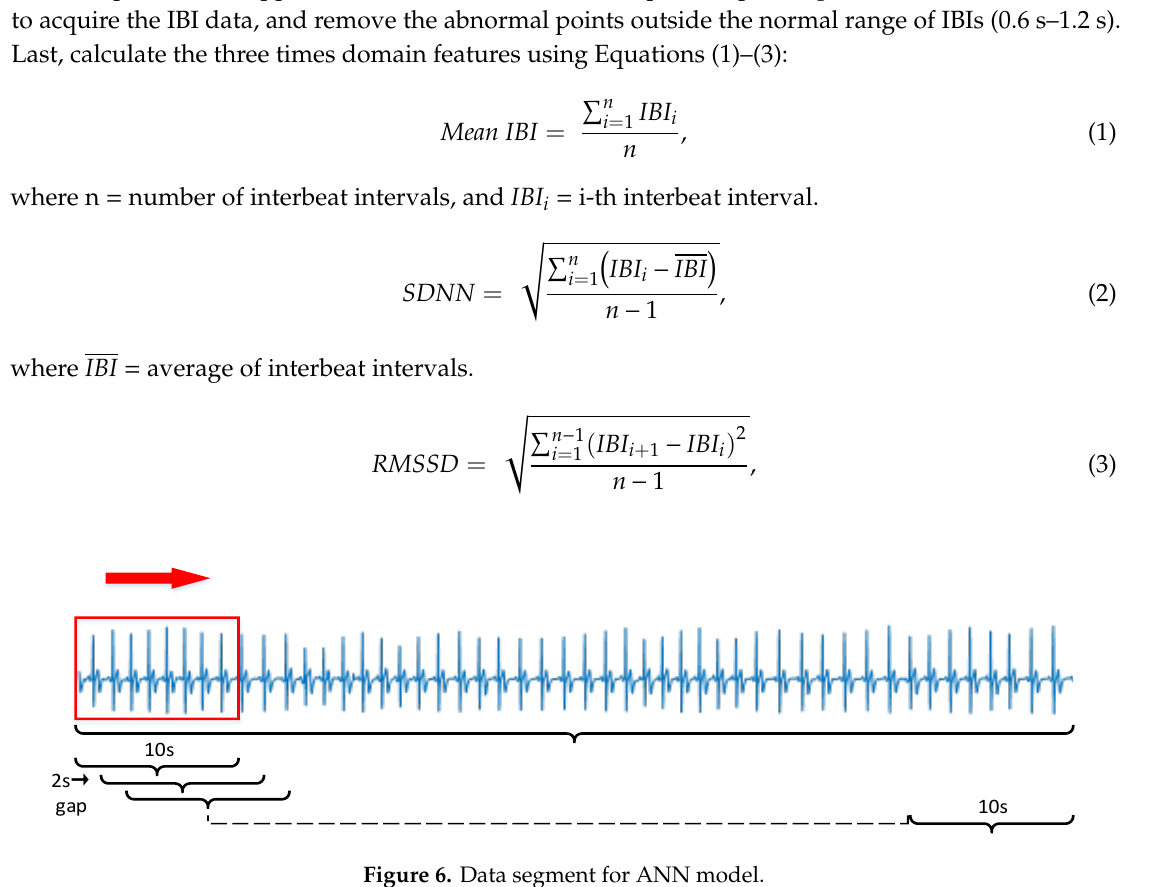
Figure 7. Three-layer ANN model structure.